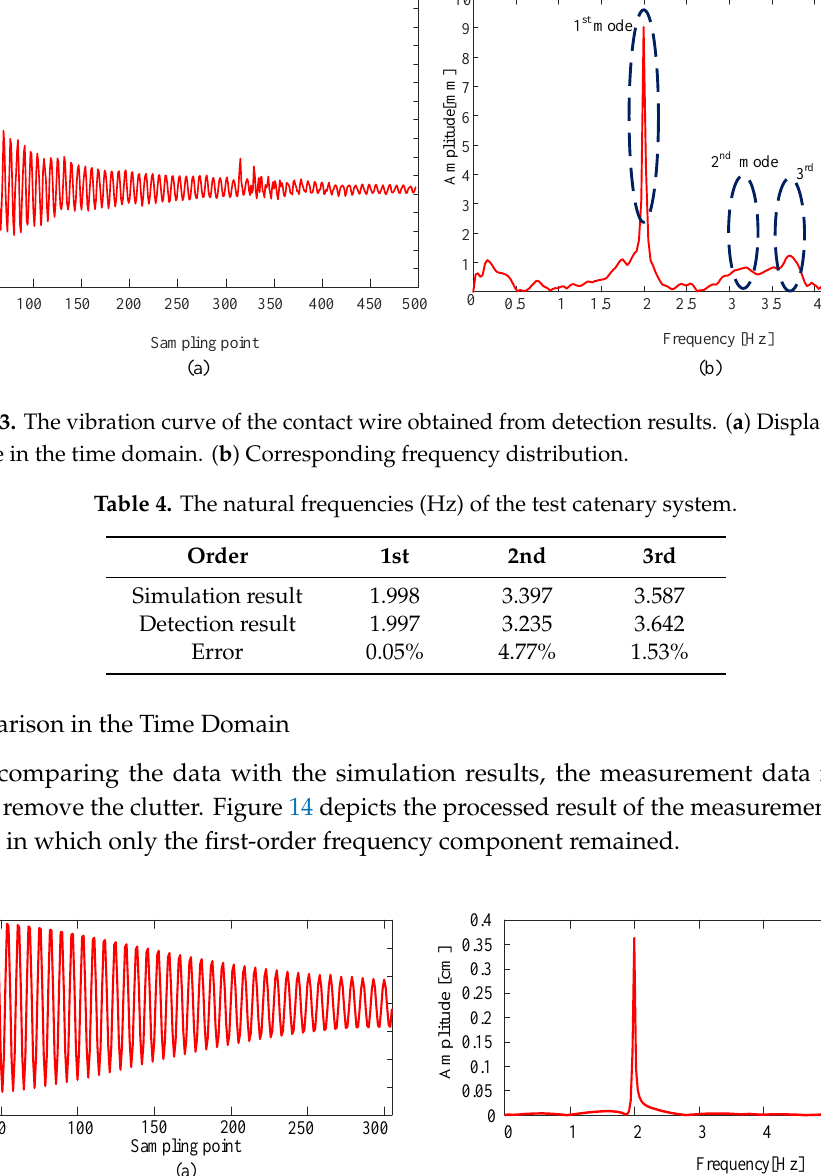
Figure 14. Processed result of the measurement data. ( a ) The vibration curve of the contact wire after removing clutter. ( b ) The corresponding frequency distribution of the processed curve.